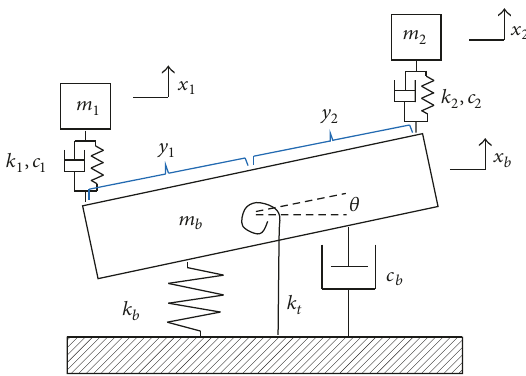
Figure 2: Schematic of a multimode TMD